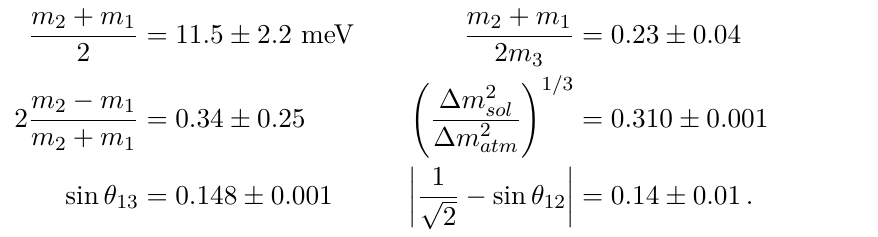
Table 2 . Transformation properties of the fields u and Φ under the group G 0 and CP. See the text for the definitions of the involved